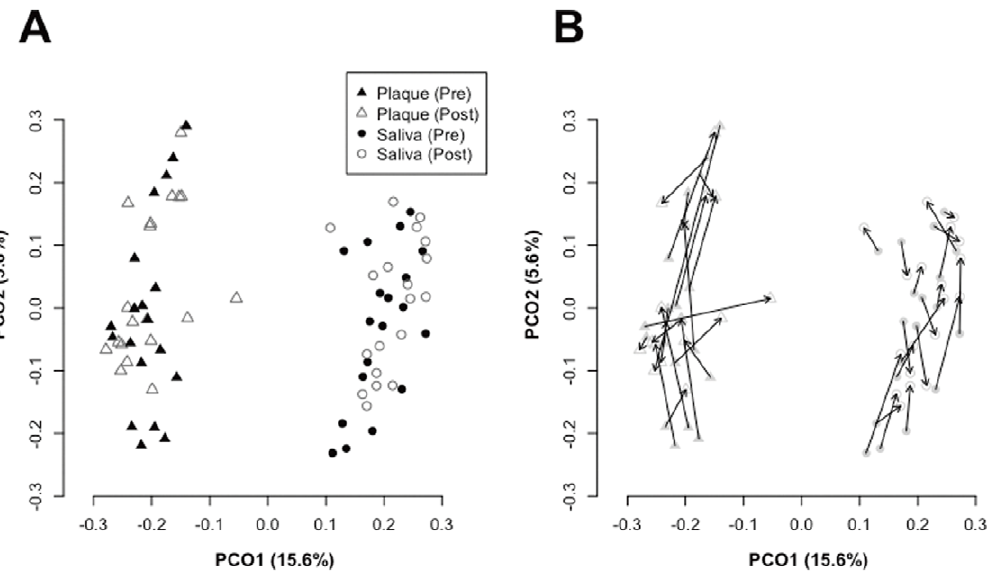
Figure 1. Principal coordinate analysis (PCoA) plot. (A) Similarity relations among the 76 bacterial community samples. Plots were generated using the unweighted UniFrac metric. These two components explain 21.2% of the variance. (B) Microbiota shift after periodontal therapy. Pre- and post-therapy supragingival plaque or saliva samples from the same subjects are connected by arrows. doi:10.1371/journal.pone.0042806.g001 PLOS ONE |